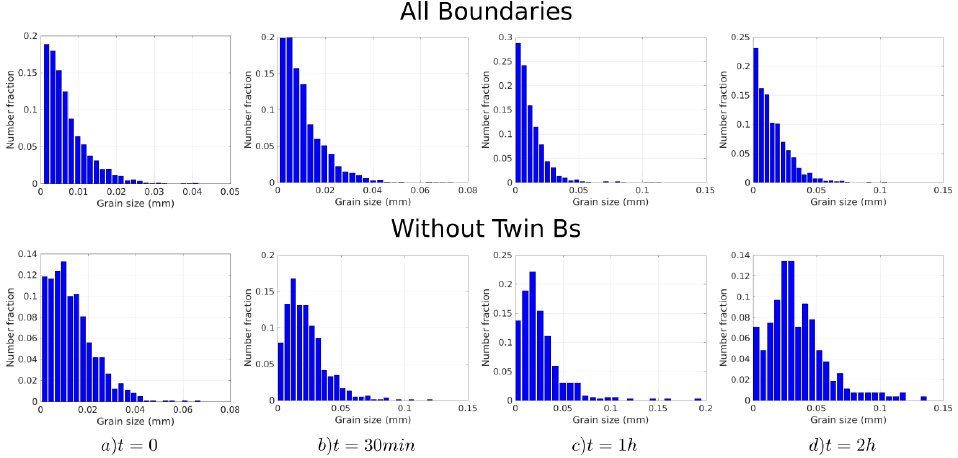
Figure 4. From left to right: evolution of the grain size histograms (in number) at t = 0 s, t = 30 min, t = 1 h, and t = 2 h. ( Top ): All boundaries are considered. ( Bottom ): Σ 3 twin boundaries are excluded.